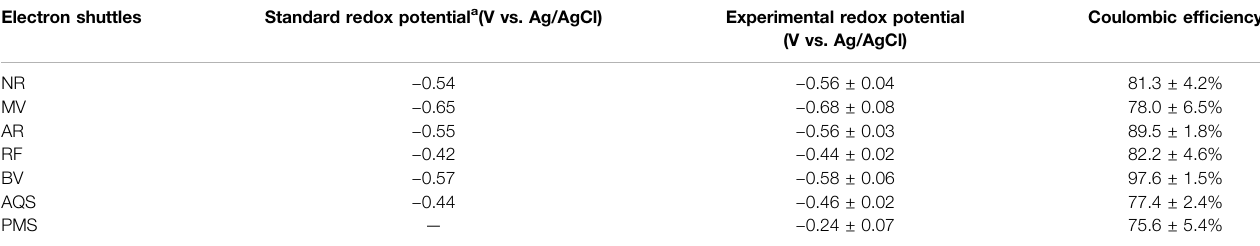
TABLE 2 | Redox potentials of ESs and Coulombic ef fi ciencies in MES. Electron shuttles